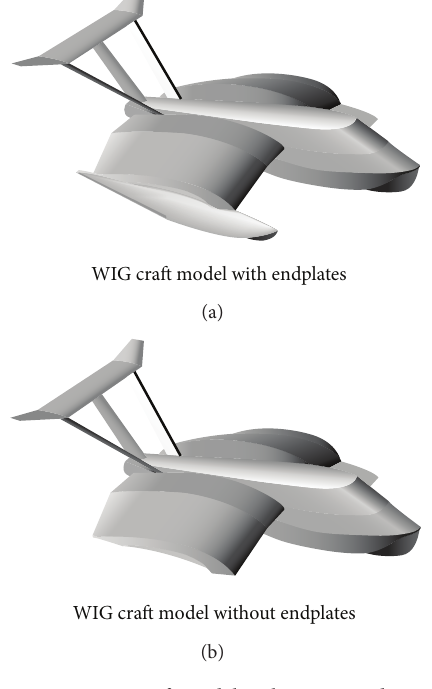
Figure 3: WIG craft model with compound wing.